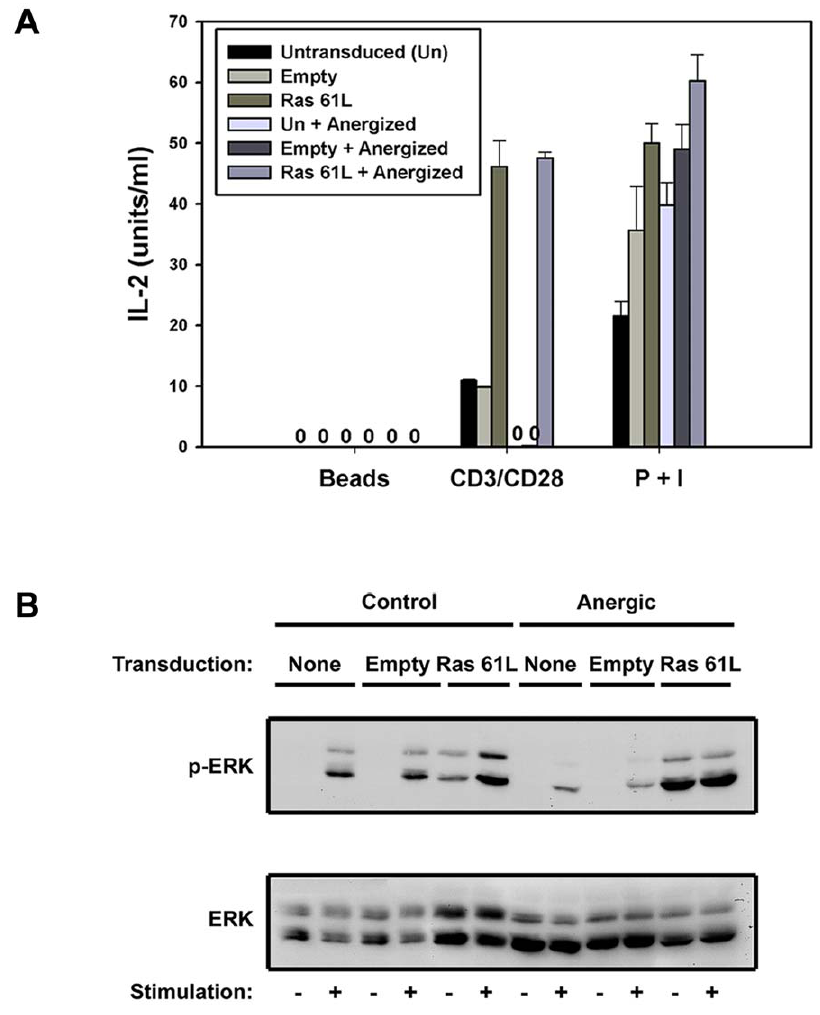
Figure 3. Active Ras can recapitulate CD28-mediated anergy prevention. A. CAR Tg Th1 cells were left untransduced or transduced with empty vector or Ras61L. They were then rested or submitted to anergy-inducing conditions as described in the materials and methods. A. These cells were then restimulated overnight with non-coated or antibody coated beads or PMA and ionomycin and supernatants were assessed for IL-2 production by ELISA. Error bars represent the standard deviation of mean values from triplicate samples from the same experiment. Cells transduced with active Ras prior to anergy induction produced significantly more IL-2 in response to CD3 and CD28 stimulation when compared to cells transduced with empty vector prior to anergy induction (p , 0.05). B. Additionally, these cells were analyzed for pERK generation by western blot after 30-minute stimulation with anti-CD3 and anti-CD28 coated beads.